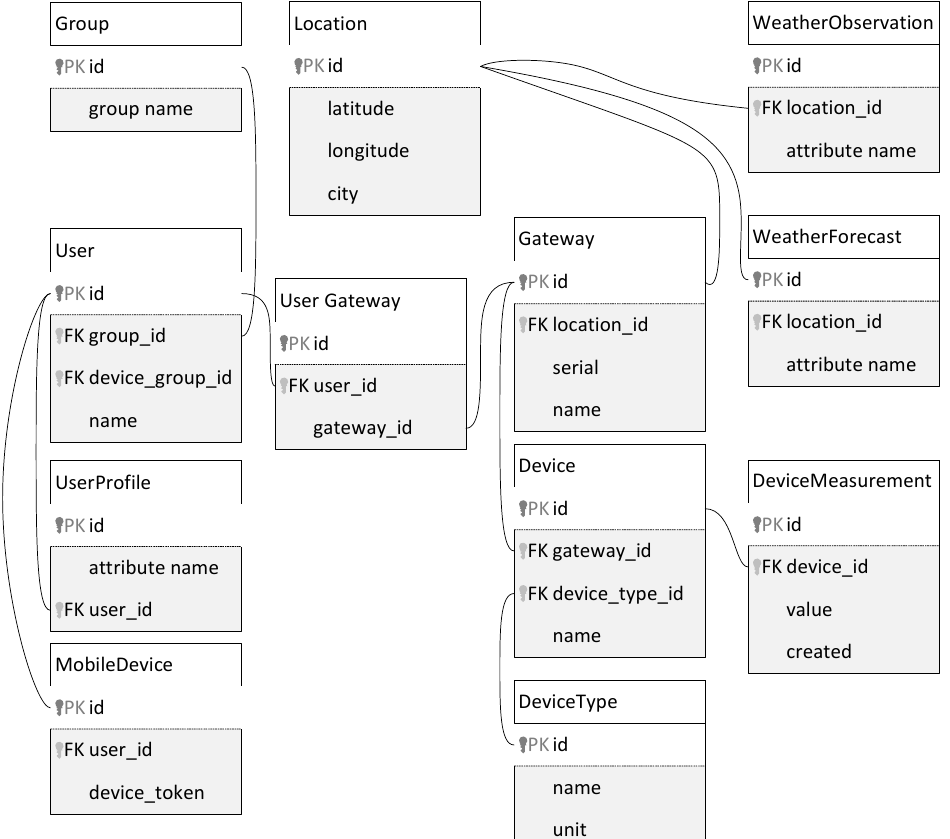
Figure 8. The Winet MySQL database